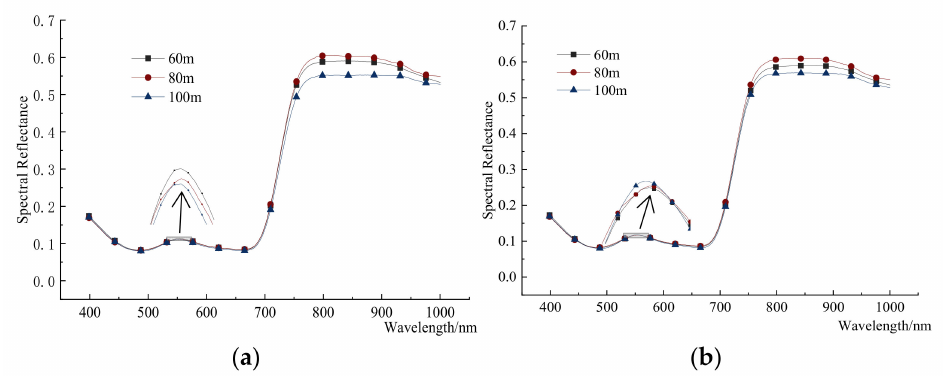
Figure 6. Change trend of hyperspectral reflectance of UAV at different heights ( a , b ) denote the test set and verification set, respectively, and the results are consistent).